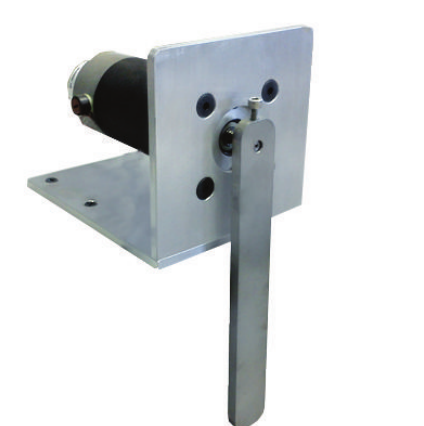
Figure 9: Experimental one-degree-of-freedom arm (pendulum) subject to gravitational force.